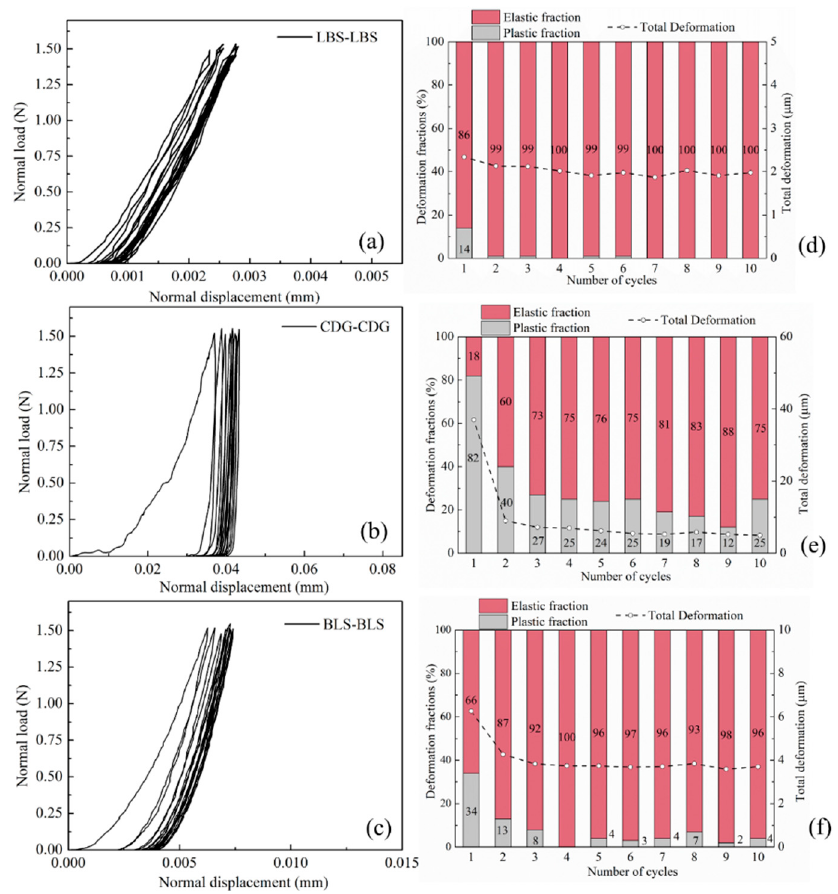
Figure 7. Load–displacement curves of cyclic loading for LBS–LBS, CDG–CDG, and BLS–BLS ( a – c ) and corresponding displacement fractions ( d – f ).